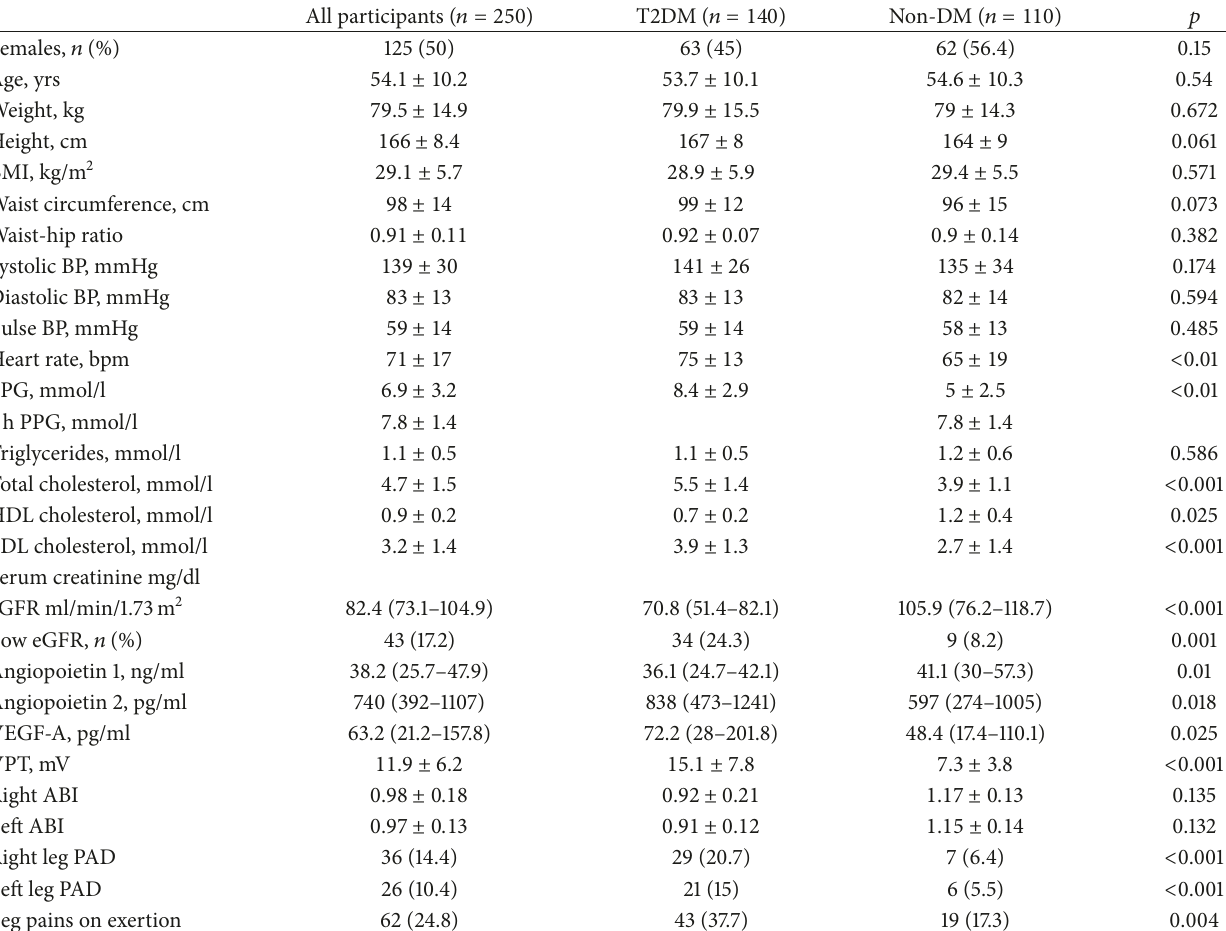
Table 1: General characteristics of study participants by diabetes